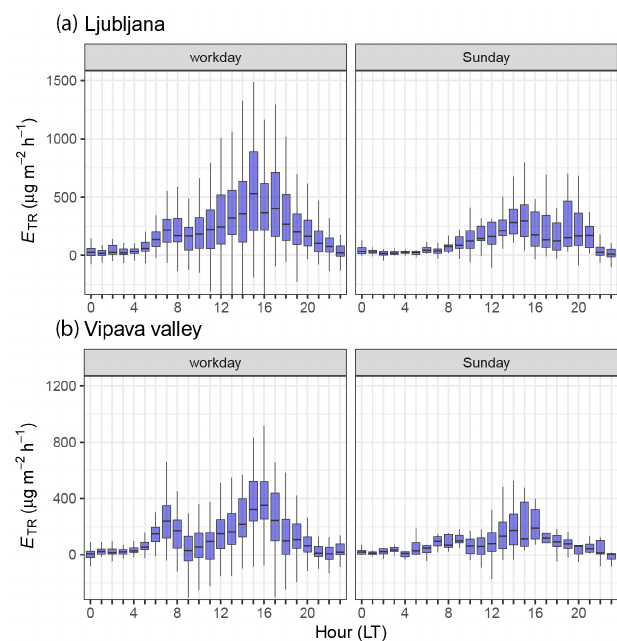
Figure 10. Diurnal variation (local time: CET/CEST) in emission rate of traffic-related BC ( E TR ) in Ljubljana (a) and Vipava val- ley (b) , grouped by working days and Sundays. The statistics for every hour in a day are represented by a box plot (horizontal line: median; blue-coloured box: 25th–75th percentiles; whiskers: 5th– 95th